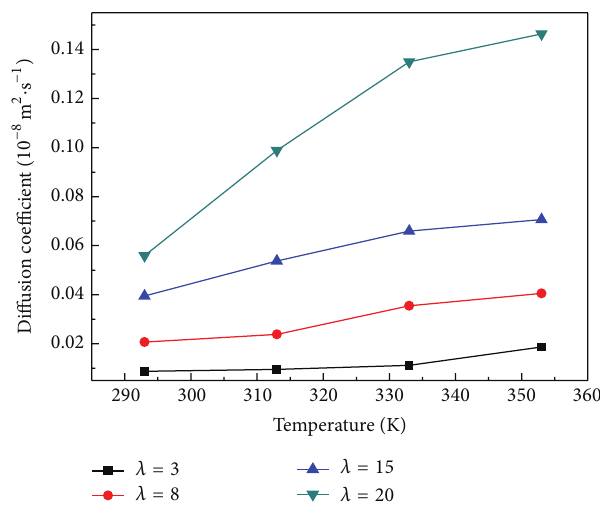
Figure 4: The RDFs of different pairs of particles (see legend) at 𝜆 = 8 and 𝑇 = 333 K.